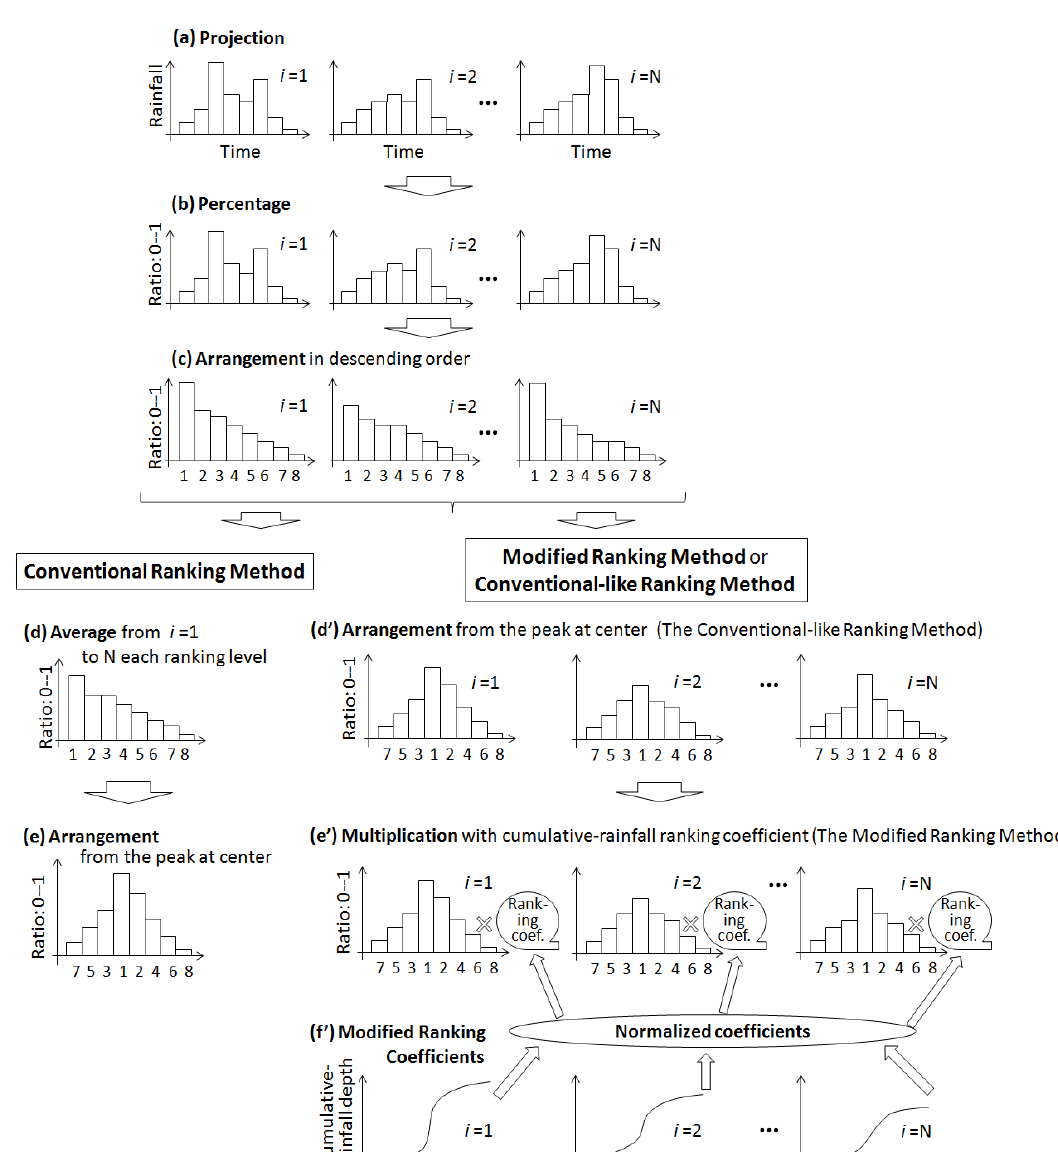
Figure 3. Procedure for creating the design hyetograph. Note that the ranking coefficient is the coefficient for the modified ranking